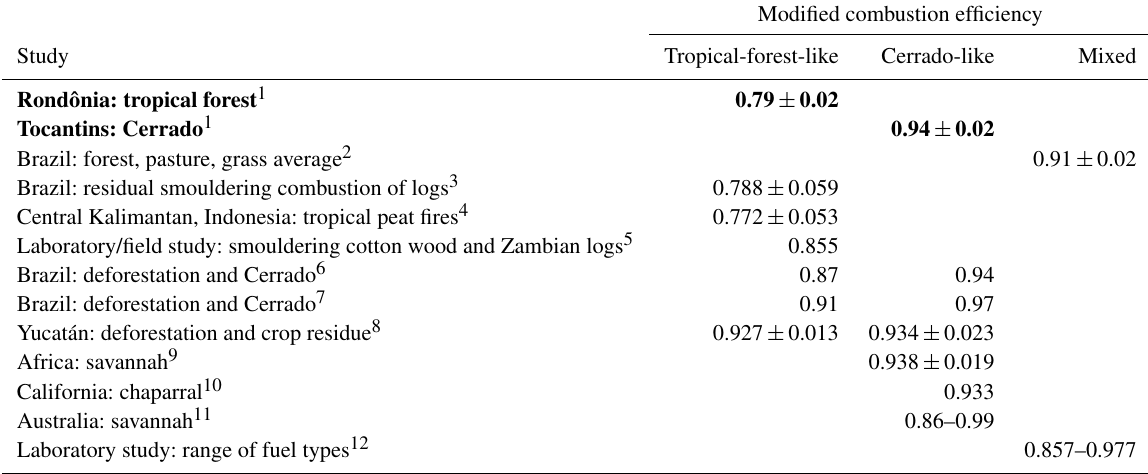
Table 1. Modified combustion efficiency (MCE) for the Rondônia fire and the Tocantins fires. Calculation methods as described in Sect. 2.2.2. Also included are other studies MCEs from Brazil and from other locations with the specific fuel type quoted. Values in bold are from this study.